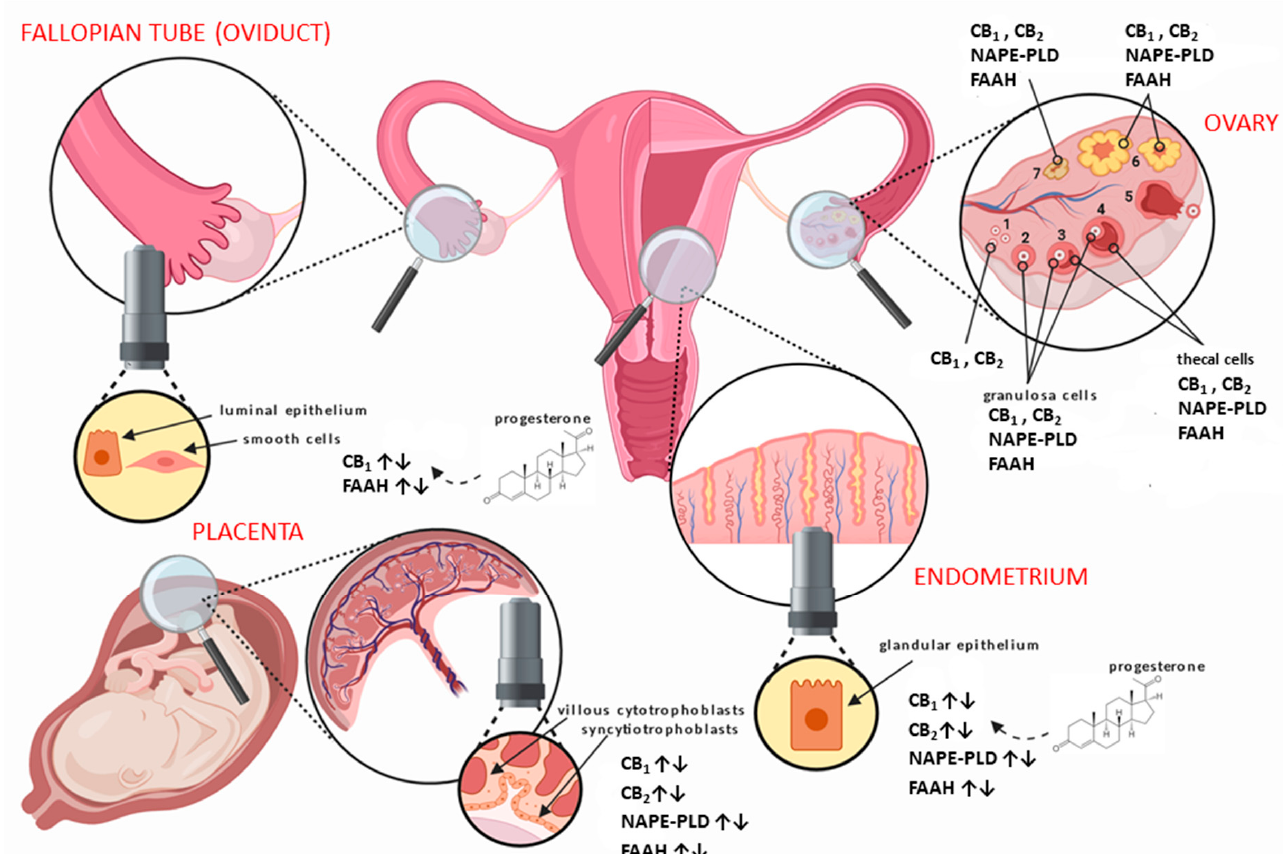
Figure 1. Distribution of the main endocannabinoid system (ECS) components in human female reproductive tissues. In the ovary, the different stages of follicular development from (1) primordial/primary, (2) secondary, (3) tertiary, (4) pre-ovulatory/Graafian, to (5) ovulating follicles are depicted. After ovulation is complete, the condensing granulosa and mural thecal cells form the corpus luteum (6), a structure that produces the progesterone required for continued early pregnancy. In the absence of pregnancy, the corpus luteum degenerates into the corpus albicans (7). Throughout the ovarian cycle, CB 1 (type 1 cannabinoid receptor) and CB 2 (type 2 cannabinoid receptor), fatty acid amide hydrolase (FAAH), and N -acylphosphatidylethanolamine-specific phospholipase D (NAPE-PLD) are produced in the various cells of the developing follicle and corpus luteum, including the oocyte [45]. Similarly, CB 1 , CB 2 , FAAH, and NAPE-PLD are expressed in the Fallopian tube [49] and endometrium [47] throughout the menstrual cycle, where they are regulated by the actions of estradiol and progesterone. The cytotrophoblast and syncytiotrophoblast cells of the early placenta also express CB 1 , CB 2 , FAAH, and NAPE-PLD [48], where modulation of protein expression occurs when production of progesterone changes from the corpus luteum to the placenta.